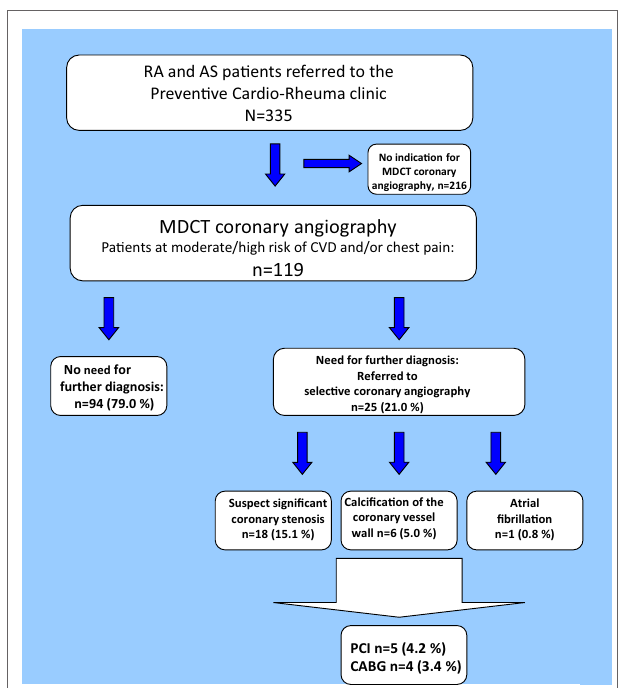
FigUre 4 | results of the MDcT coronary angiography . Flowchart of patients undergoing MDCT coronary angiography. MDCT, multidetector computed tomography; CA, coronary atherosclerosis; PCI, percutaneous coronary intervention; CABG, coronary artery bypass